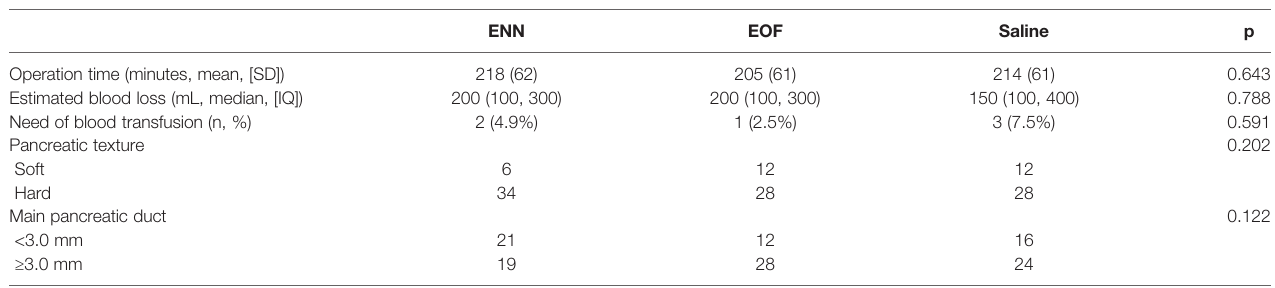
TABLE 2 | Intraoperative